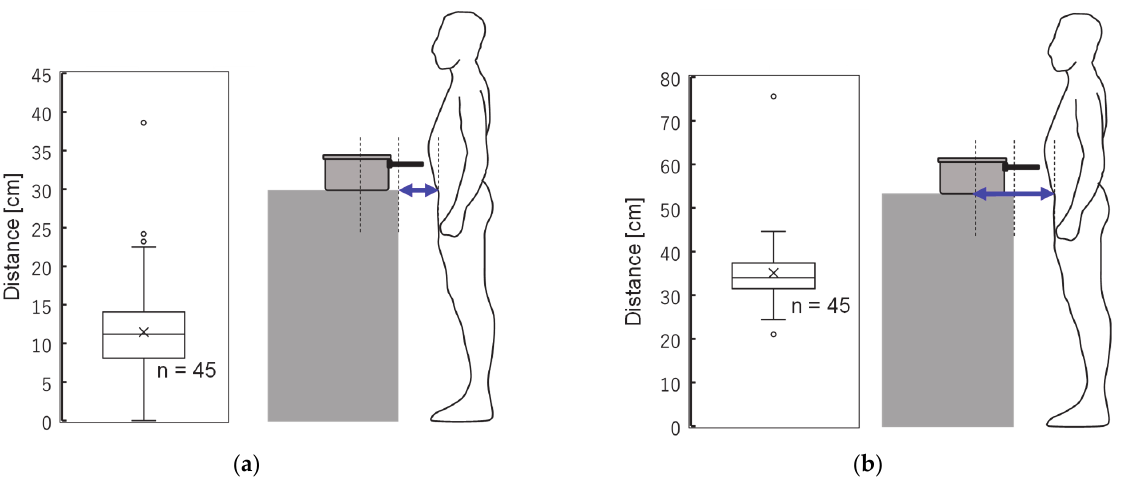
Figure 3. Distance distribution between cooking device and body surface in the participants’ usual posture (cm): ( a ) distance of body surface from cooking table edge and ( b ) distance of body surface from hob. For the center at distance ( a ) the average was 11.2 cm and at distance ( b ) it was 35.0 cm.